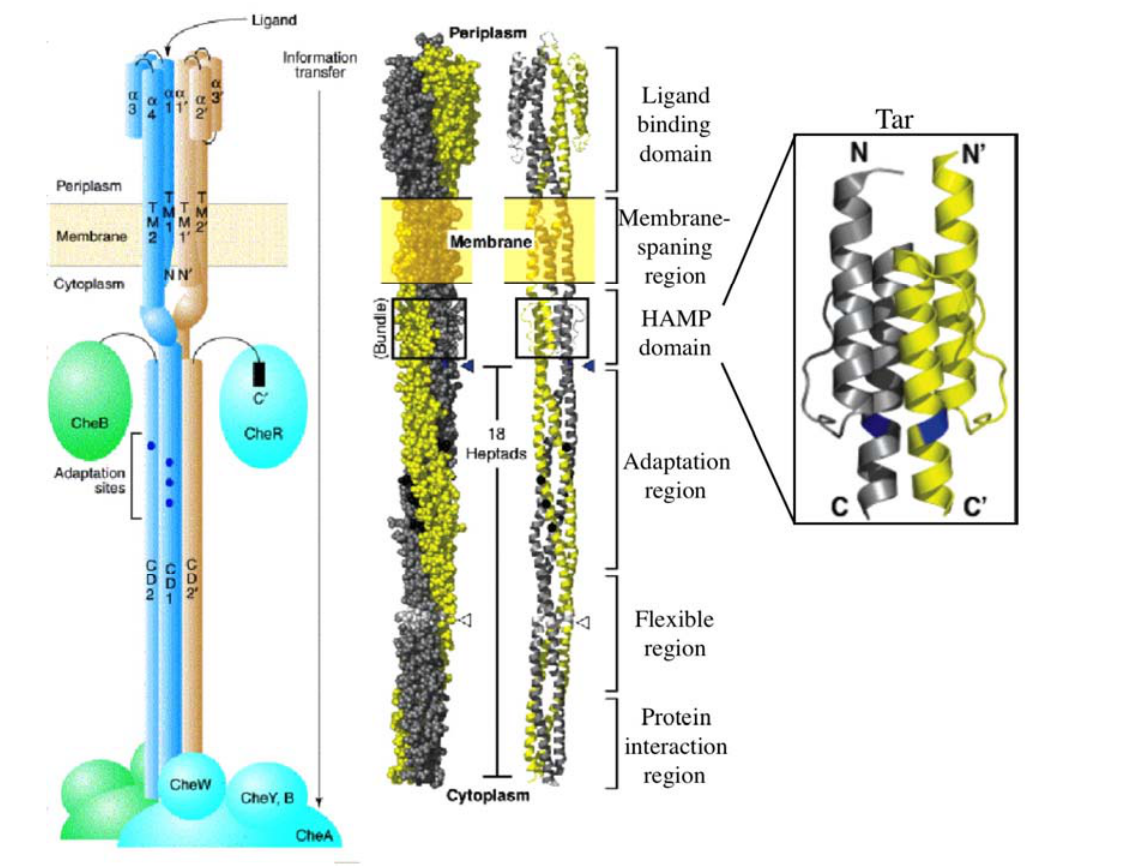
Figure 8. Structure of a dimeric bacterial chemoreceptor. (Left) Schematic illustration of the chemoreceptor. Each receptor monomer (~60 kDa) consists of an N-terminal periplasmic ligand-binding domain, two transmembrane regions (TM1, TM2), a linker region and a C-terminal signaling/adaptation domain. Note that the HAMP domain structure is not integrated. (Center) Atomic structural model of the chemoreceptor generated by combining crystal structures of the fragments. The two symmetric subunits of the homodimer are shown as different colors. (Right) Deduced structure of the HAMP domain of the aspartate chemoreceptor Tar. Adopted from reference [140] and